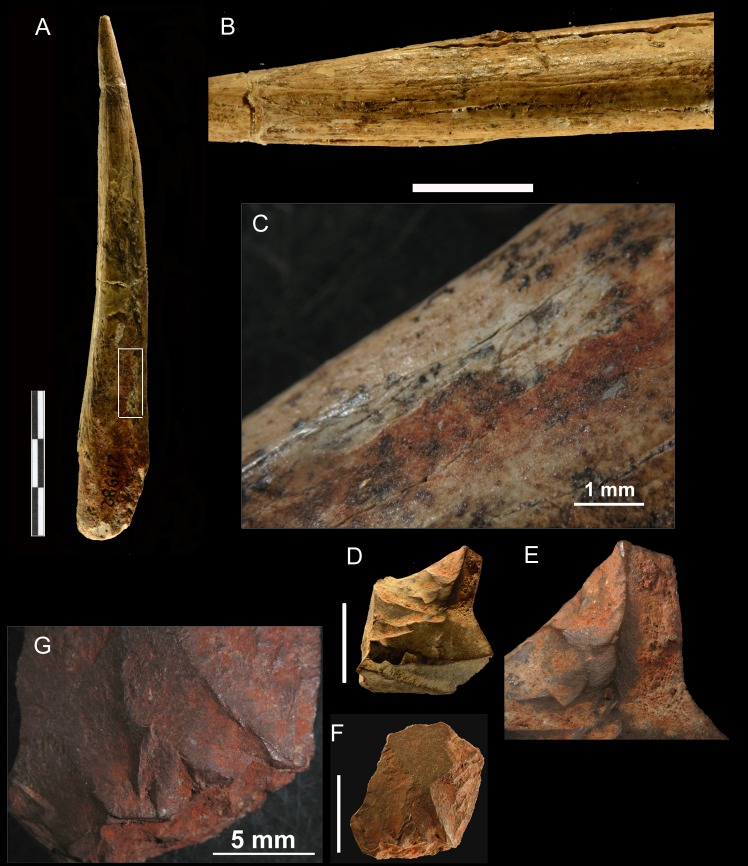
La Fabbrica, layer 2.Ochre-stained bone awl and small flakes covered with ochre. (A) Bone awl, 12 cm long, on a horse accessory metapodial. (B) scraping marks on the awl. (C) detail of ochre stained area. Two small flakes covered with ochre (D, F) and details of ochre coating on flakes (E,G). The scale of B, D, F is 1 cm; the scale of A is 3 cm.